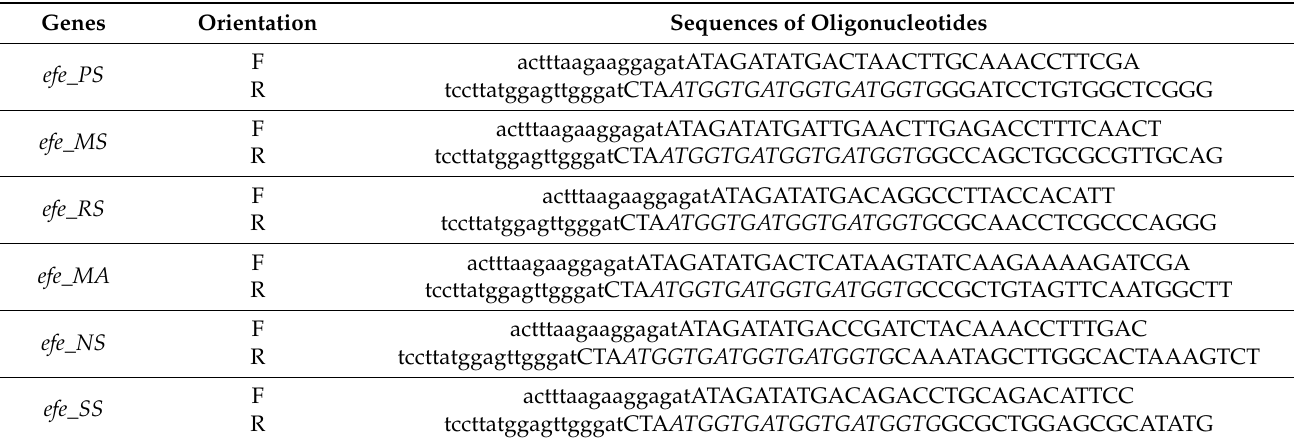
Table 4. Primers for the construction of E. coli vectors expressing six ethylene forming enzymes were used in this